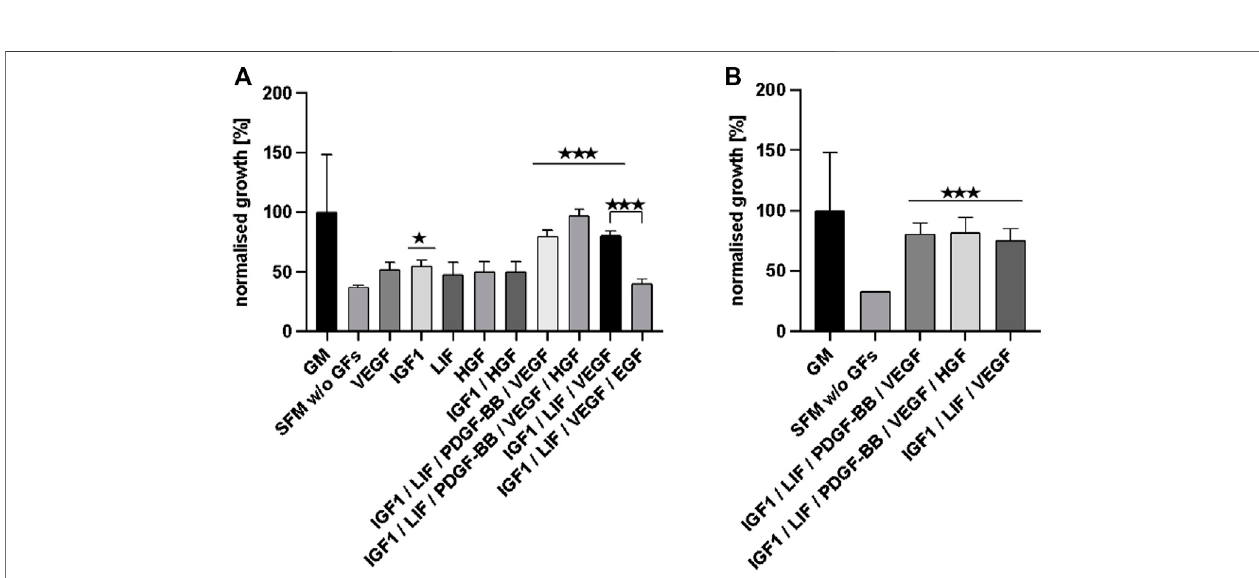
FIGURE4|(A) displays theeffects thatsigni fi cantgrowth factorsand growthfactor combinationshadoncellgrowth (according toJMP analysis)incomparison to SFM w/oadditionalGFs(apartfromFGF-2).Dataisnormalisedas%ofgrowth compared tothecontrol(GM). Thethree mosteffectivegrowth factorcombinationswere tested again and the results are shown in (B)